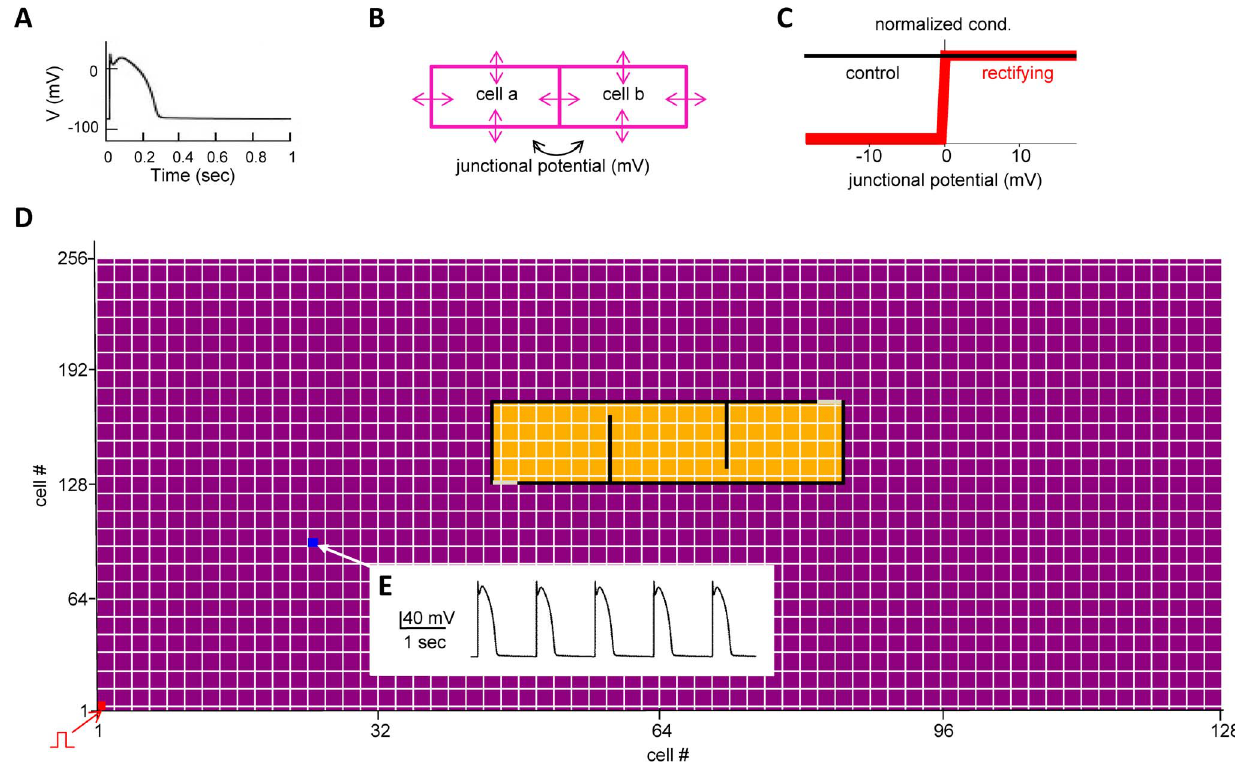
Figure 1. Model implementation. A) the action potential of an isolated cell in response to a short current pulse injection (4 nA, 5 ms); B) schematic representation of the gap junctions connecting neighbor cells, represented by arrows; C) the gap junction conductance as a function of the junctional potential under control conditions (black line) and for cells forming the edges of the fibrotic area (red line); D) Schematic representation of the full 128 6 256 cell network; individual cells are represented with small purple (normal) or yellow (ischemic) rectangles; the black lines identify the contour of the lesion, composed by non-conducting cells (i.e. g=0). Cells with rectifying gap junctions, implementing entry and exit doors are shown in gray. Physiological input signals from Purkinje cells were modeled by periodically stimulating with a short current pulse cell(1,1) (bottom left of the network, shown in red); E) typical membrane potential of cell(25,100) under physiological conditions (i.e. no ischemic area).